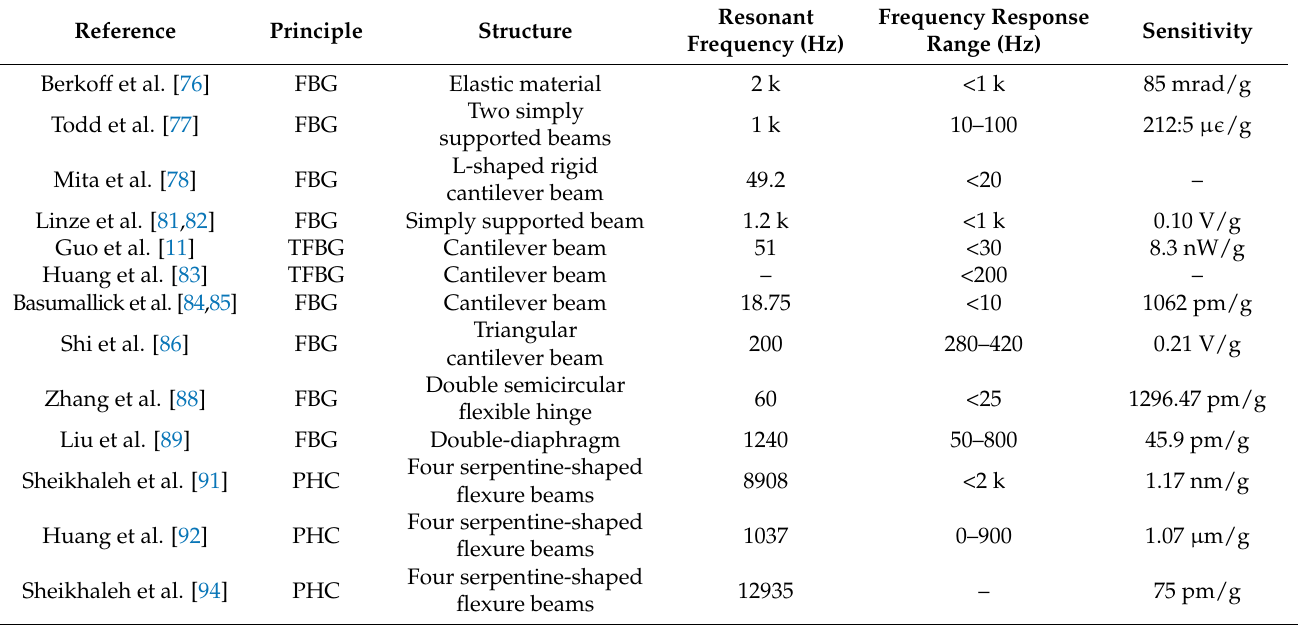
Table 4. Parameters of the accelerometer based on optical wavelength